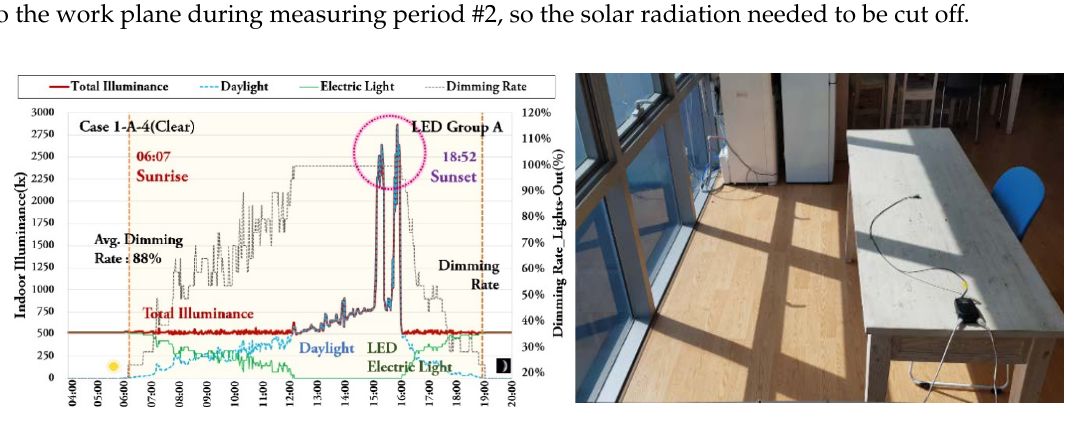
Figure 15. Introduction of direct sunlight to the work plane during measuring period #2